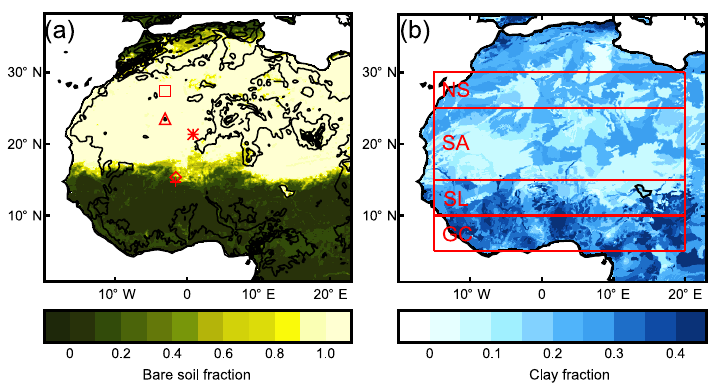
Figure 1. Maps of (a) bare-soil fraction for 12km models (filled contours) with orographic height (open contours from 0.2 with 0.4km interval). Locations of Fennec and AMMA stations marked in red: square F138 (27.4 ◦ N, 3.0 ◦ W), triangle F134 (23.5 ◦ N, 3.0 ◦ W), asterisk Bordj Badji Mokhtar (21.3 ◦ N, 0.9 ◦ E), diamond Agoufou (15.3 ◦ N, 1.5 ◦ W) and cross Kobou (14.7 ◦ N, 1.5 ◦ W) and (b) clay fraction from Harmonised World Soil Database (HWSD) used to define surface soil texture in the models. Red boxes highlight regions referenced in Fig. 3 (northern Sahara (NS, 25–30 ◦ N), the Sahara (SA, 15–25 ◦ N), the Sahel (SL, 10–15 ◦ N) and the Guinea coast (GC, 5–10 ◦ N), all with longitudes 15 ◦ W–20 ◦